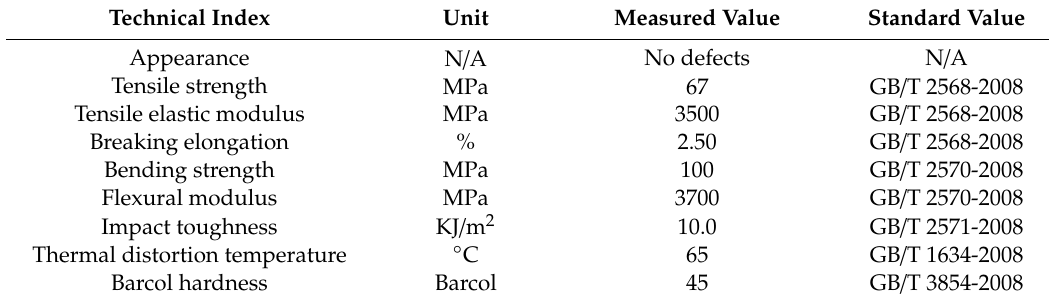
Table A10. Technical parameters of resin casting